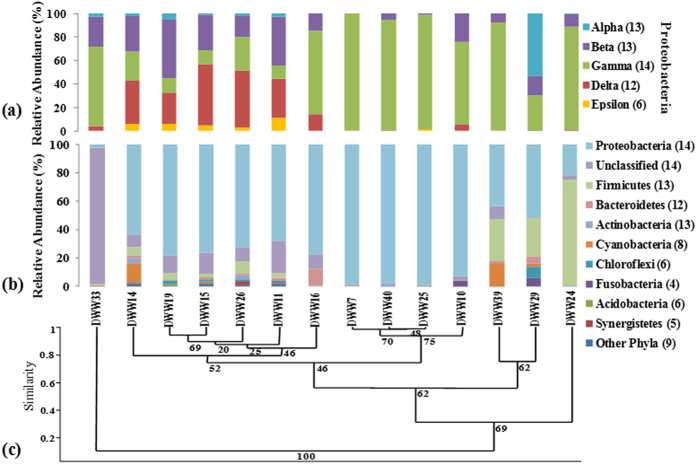
Comparison of bacterial diversity between the different DWW samples.(a) Stacked column graph representing relative percent abundance of classes within the phylum Proteobacteria. (b) Stacked column graph representing the relative percent distribution of the dominant phyla in the 14 DWW samples. Values in parentheses corresponds to the number of samples (out of 14) in which that particular phyla or class were detected. (c) Cluster analysis of bacterial diversity at the phylum level using the Bray-Curtis matrix of similarity. Low abundance phyla are grouped together as “other phyla” and their cumulative abundances are listed.